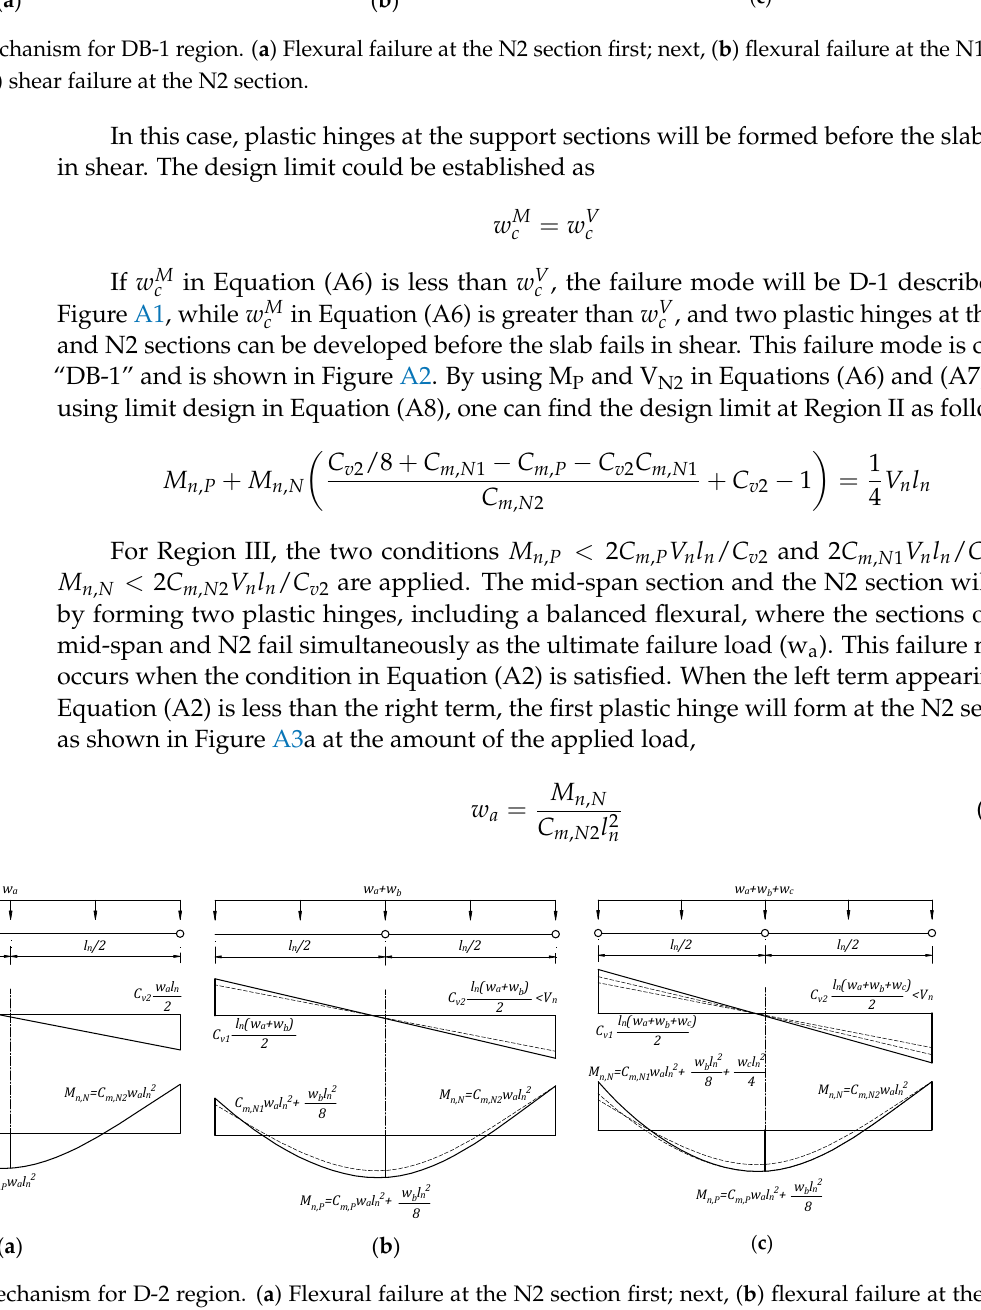
Figure A1, while 𝑤 (cid:3030)(cid:3014) in Equation (A6) is greater than 𝑤 (cid:3030)(cid:3023) , and two plastic hinges at the